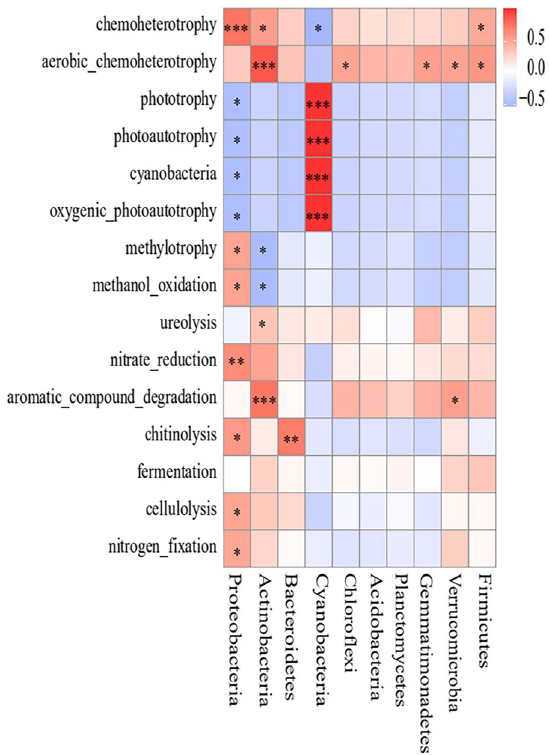
Fig. 7 Correlations between predicted functions and dominant bacterial phyla. Spearman correlations were conducted. “*”, “**” and “***” indicate significant correlations at 0.05, 0.01 and 0.001,